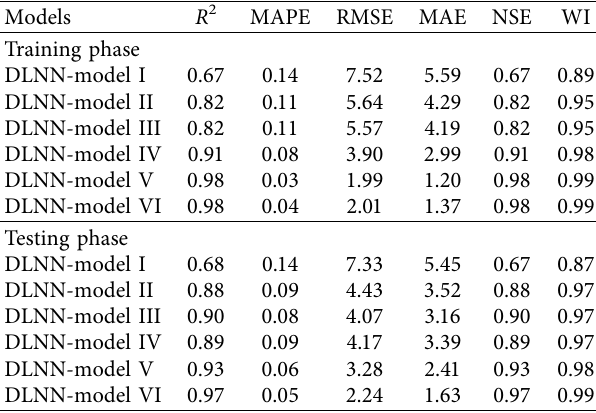
Table 12: Statistical measurements for RF model over training and testing phase for all input